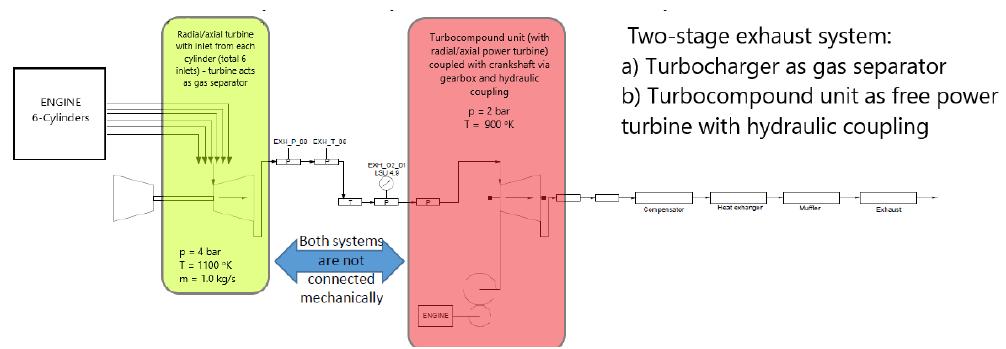
Figure 15. Conceptual adaptation of turbine wheels for an OP engine.